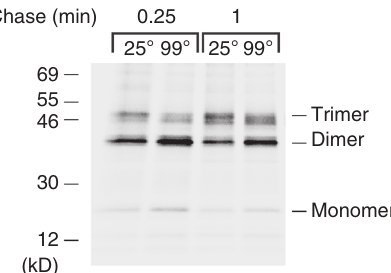
Fig. 4 The crosslinked UpaG Δ 2 dimer is derived from an unstable trimer. AD202 transformed with pRS5 [P trc - His 10 -upaG Δ 2(Y1735am) ] and pDULE- Bpa were radiolabeled, UV irradiated, and treated with PK. Following cell lysis and solubilization of cell membranes in DDM, His 10 -tagged proteins were puri fi ed by Ni-NTA chromatography and incubated at 25 or 99 °C